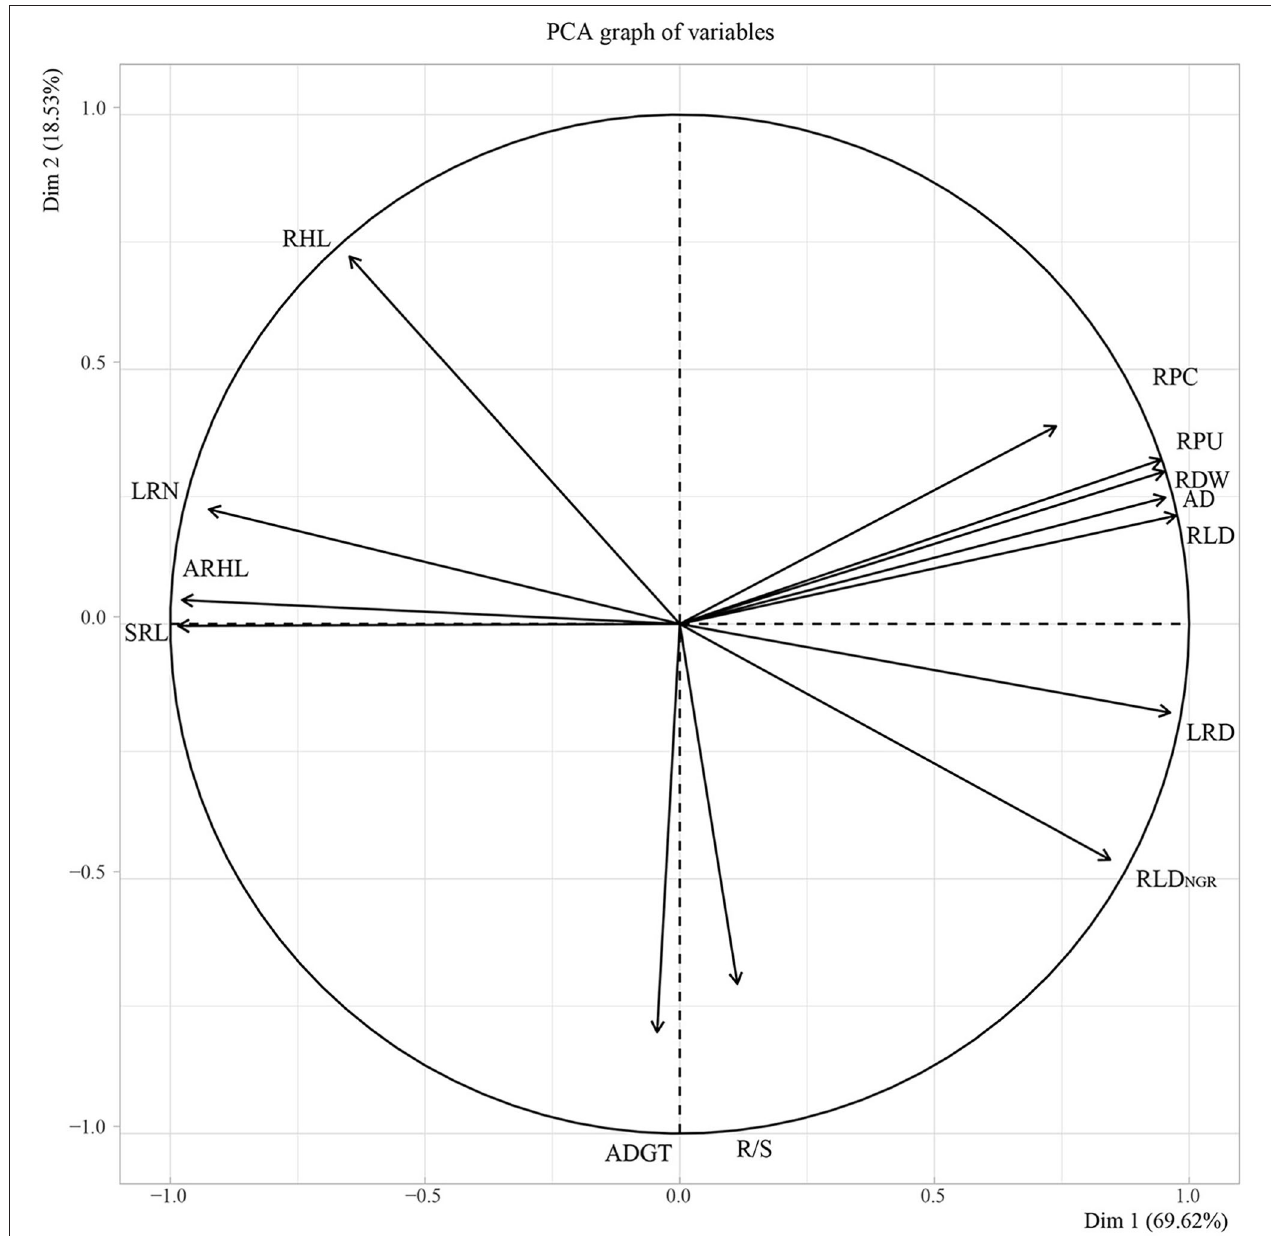
FIGURE 10 | Principal component analysis (PCA) of 11 root in situ traits. RPC, root phosphorus content; RPU, root phosphorus uptake; RDW, root dry weight; R/S, root/shoot ratio; ADGT, average daily growth of taproots; RLD NGR , the net growth rate per unit volume; RLD, root length density per unit volume; LRN, number of lateral roots; LRD, lateral root branching density; AD, average root diameter; ARHL, average root hair length; RHL, root hair life span; SRL, specific root length.